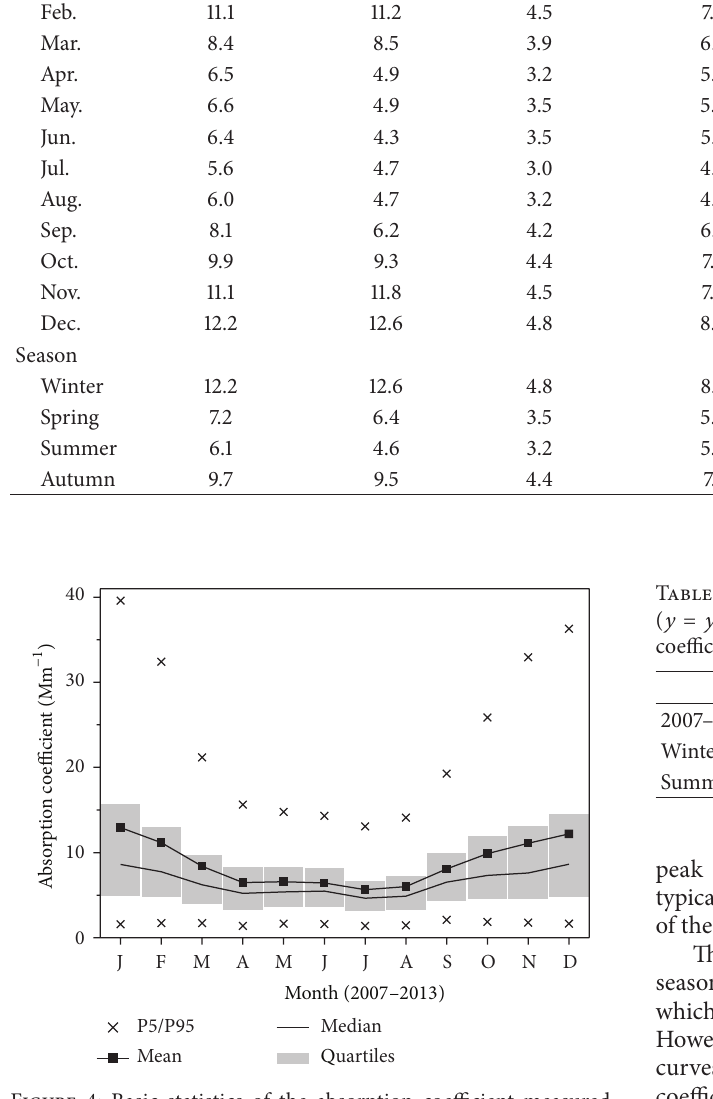
Figure 4: Basic statistics of the absorption coefficient measured between April 2007 and April 2013. Computations were based on the hourly values. The quartiles are depicted and P5 and P95 indicate the 5th and 95th percentiles.